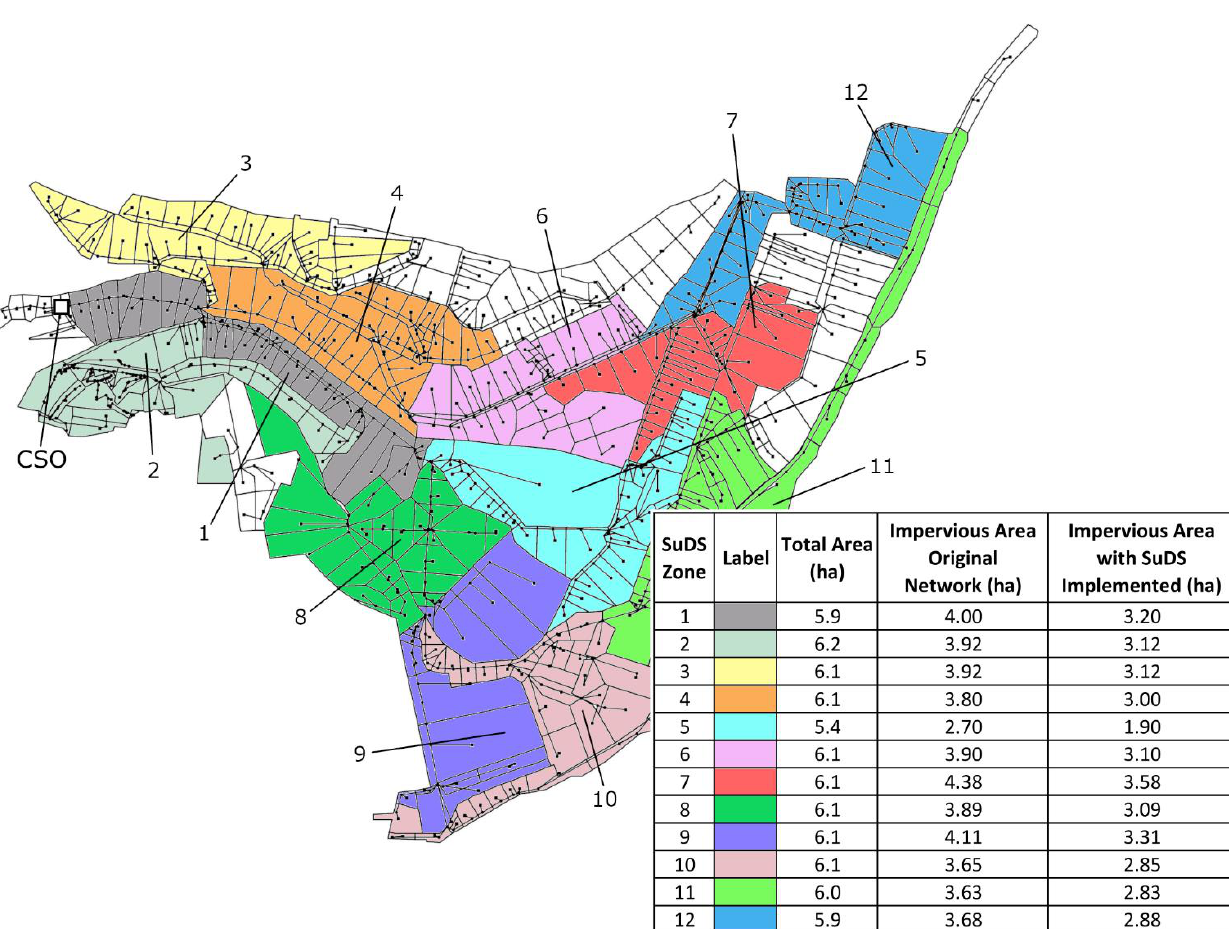
Figure 2. SuDS zones selected within the SWMM Zona Central sewer network model (0.8 hectares of impervious area were converted to pervious area in each SuDS zone).